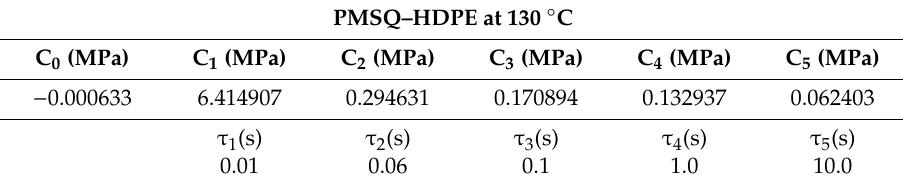
Table 3. Sti ff ness modulus and relaxation time for the PMSQ–HDPE nanocomposite at T = 130 ◦ C.